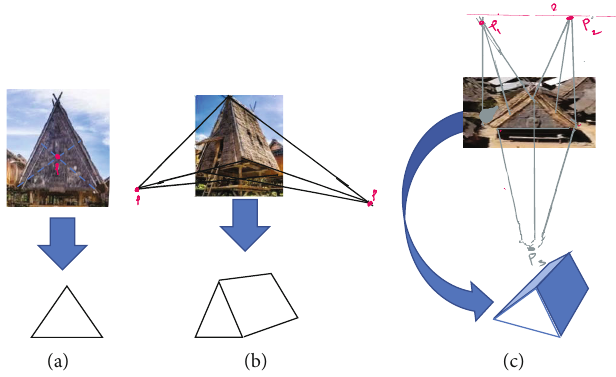
Figure 16: Uma Lengge from three di ff erent perspectives.